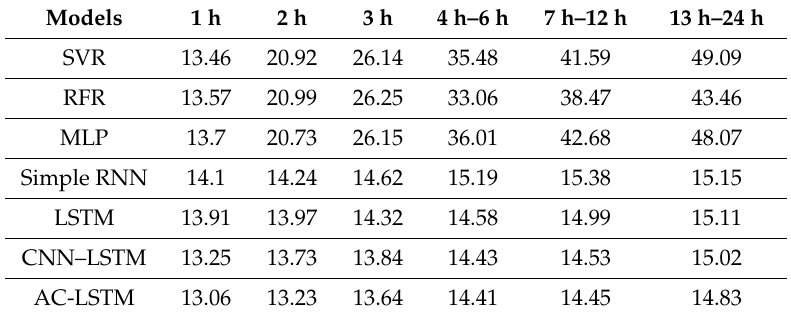
Table 7. The performances of the di ff erent models in terms of root-mean-square error